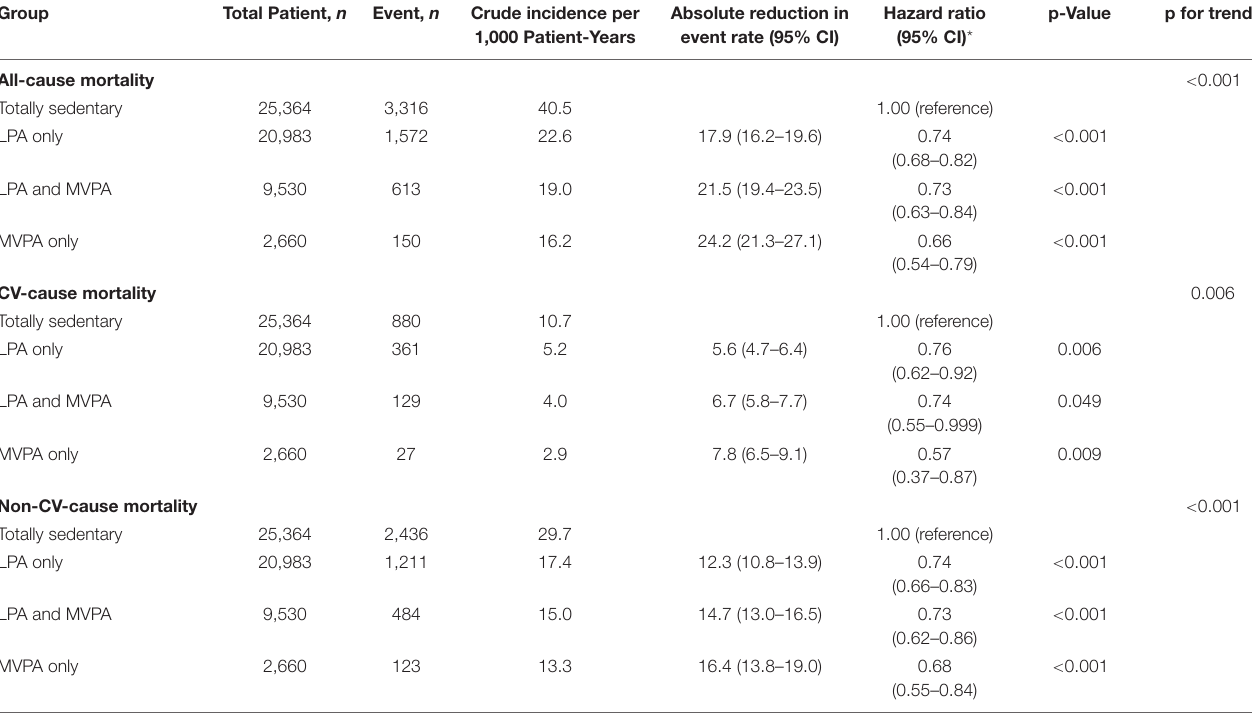
TABLE 2 | Incidence and hazard ratio with 95% confidence intervals for all-cause death, cardiovascular (CV) cause death, and non-CV-cause death according to physical activity intensity. Group Total Patient, n Event, n Crude incidence per